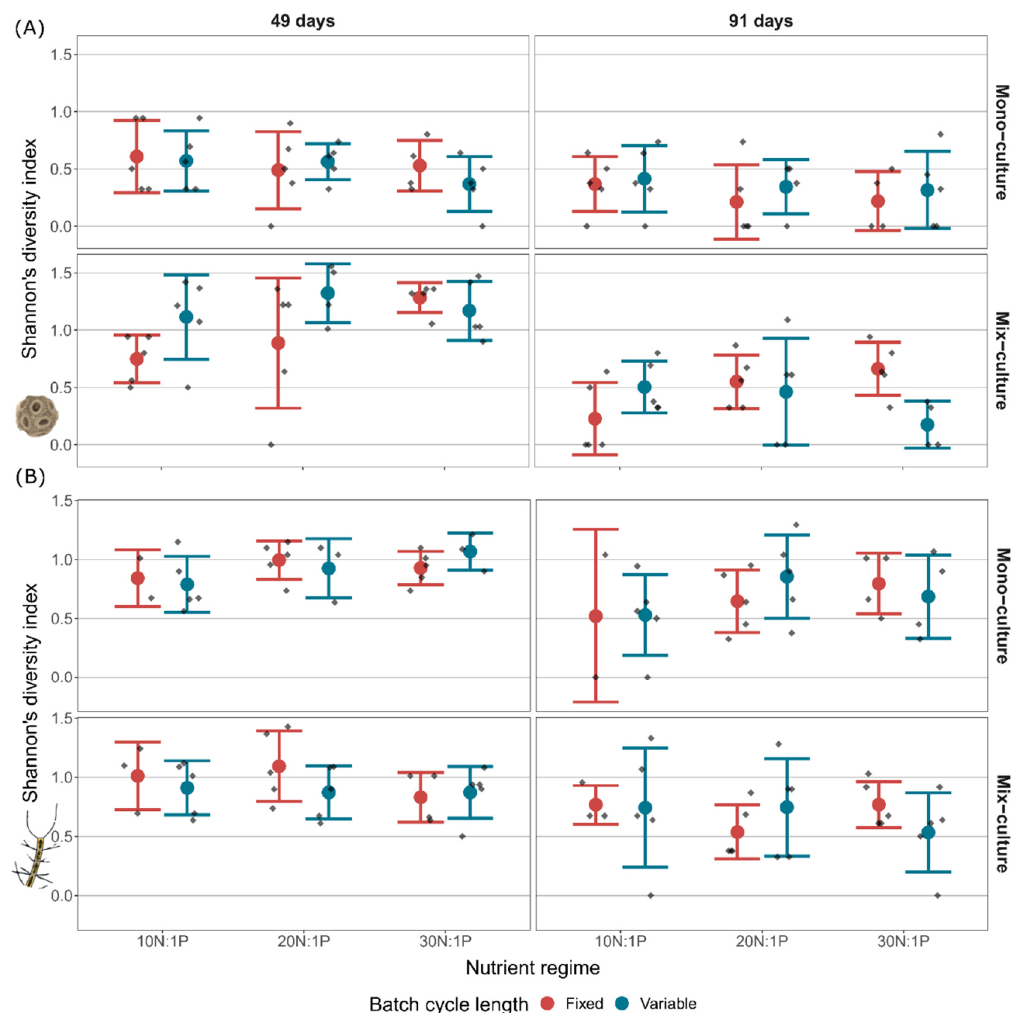
Figure 4. Shannon’s diversity of E. huxleyi ( A ) and C. affinis ( B ) genotypes at midterm (i.e., after 49 days) and at the end of the experiment (i.e., at 91 days) in mono-culture and mix-culture, at three nutrient regimes (10N:1P, 20N:1P, and 30N:1P) with fixed and variable batch cycle length. Mean±SD and data points are shown.